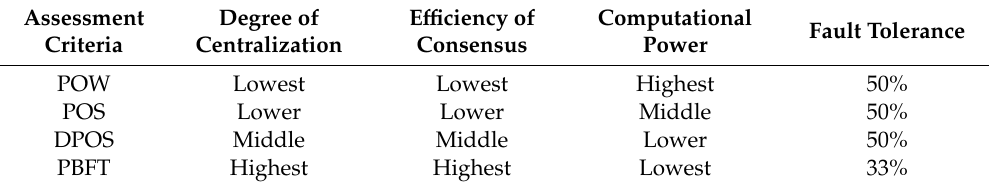
Table 2. The comparison of the typical consensus